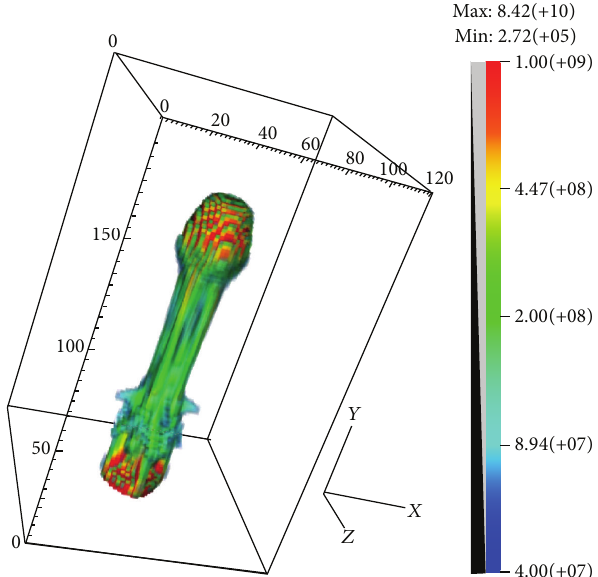
Figure 4: Unnormalized neutrino intensity, 𝐼 ] (𝐸 ] ) , on Earth as a function of the neutrino energy, 𝐸 ] , per energy interval. This neutrino intensity is coming out of the jet simulations in the presenceofthestrongtoroidalmagneticfieldthatappreciablyaffects the